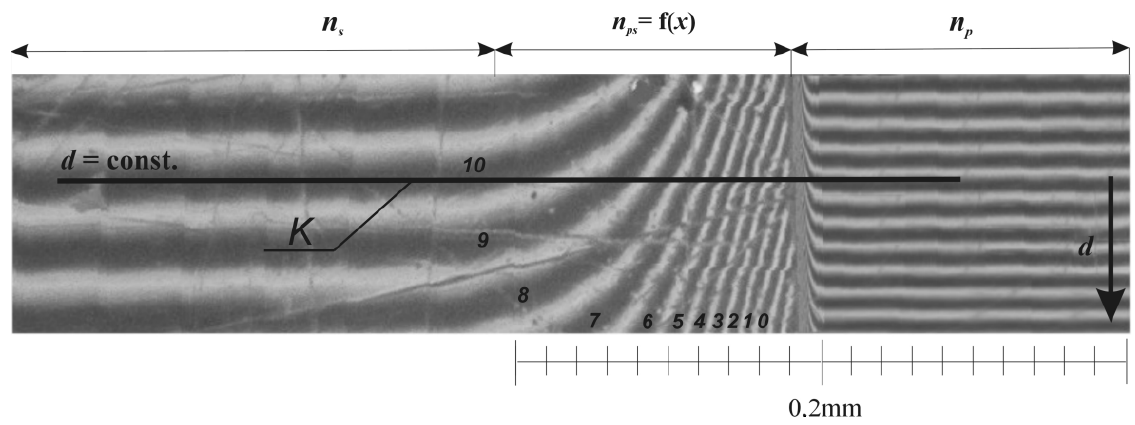
Figure 1. Interferogram obtained by the constant wedge width technique and its interpretation (sample of Hyaluronan at 37 °C in t = 210 seconds); ns – refraction index of pure solvent; of polymer; in SSL; 0, 1, 2,…,K–number of crossed lines; d–width of wedge.